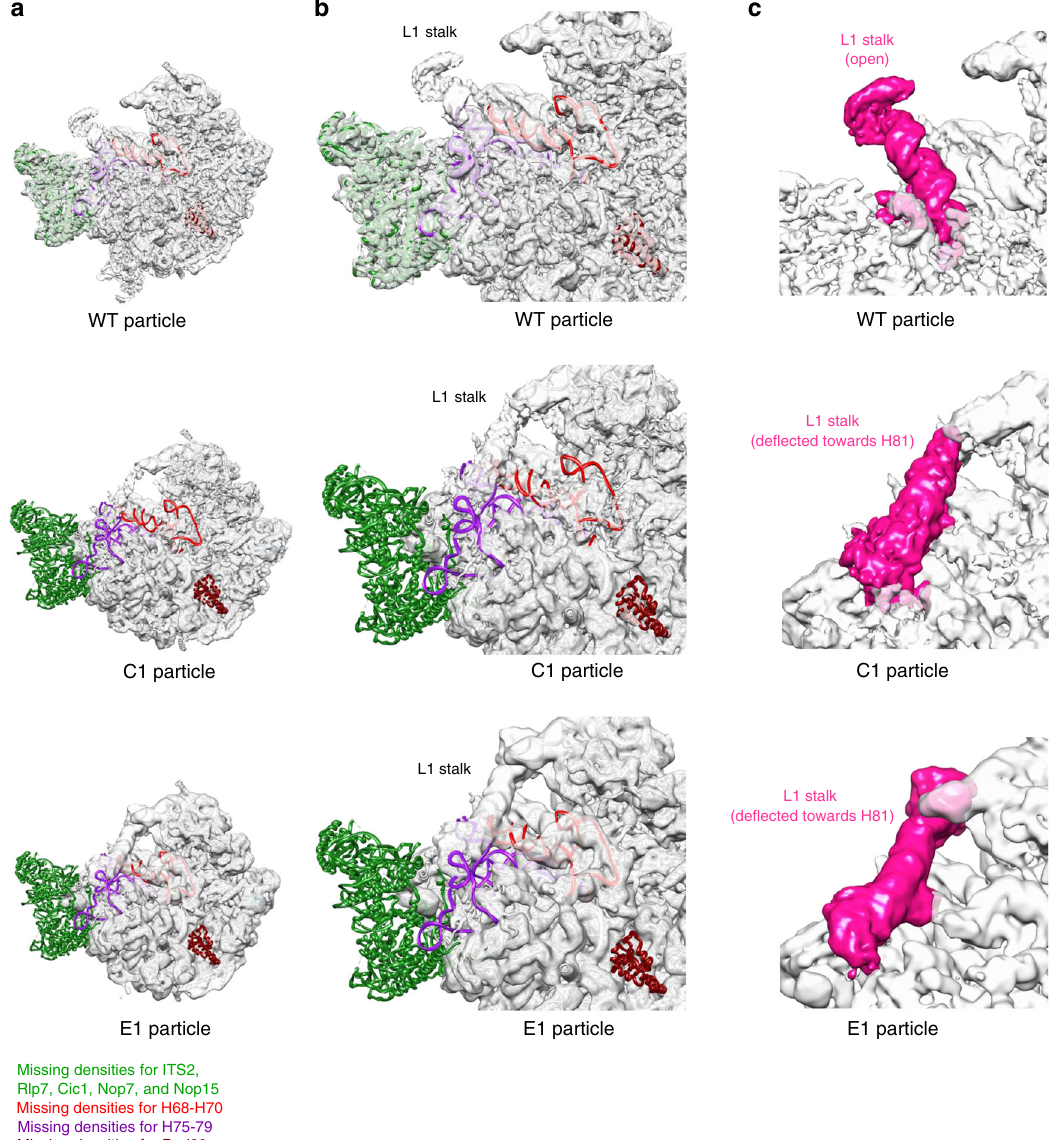
Fig. 9 The C1 and E1 classes are unusual and presumably destined for turnover. a The subunit interface view of density maps from wild-type particles, the C1 class of rpf2 Δ 255-344 mutant particles, and the E1 class of particles from Sda1-depleted yeast. The atomic model for wild-type particles was fi tted into density maps of the wild-type and E1 class of mutant particles. The atomic model for the C4 class of mutant particles was fi tted into the C1 class of mutant particles. b Enlarged view of the density maps from a . Densities for the ITS2 spacer rRNA and associated AFs Rlp7, Cic1, Nop7, Nop15, and Nop53 (all green), rRNA helices H75-79 (purple), and Bud20 (brown) are missing in the C1 and E1 classes. H68-70 (red) are missing in the C1 class, but are not signi fi cantly affected in the E1 class of mutant particles. ( c ) Enlarged portion of the density maps from (a). The L1 stalk (colored in pink) is in an unusual position in the C1 and E1 classes of particles, de fl ected toward